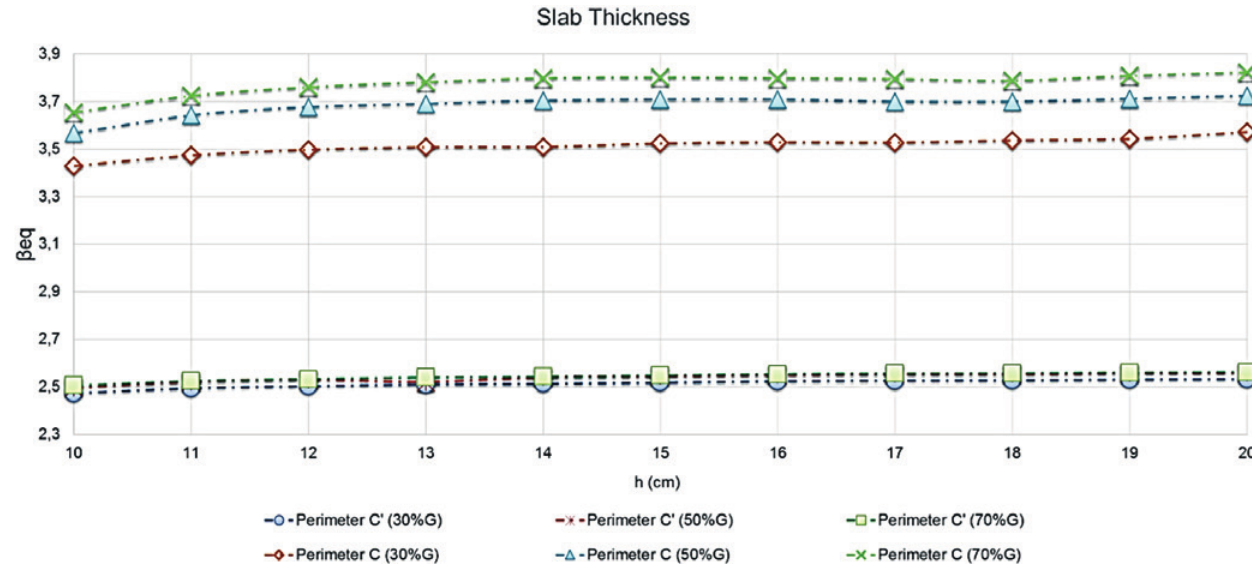
for rectangular column considering the variation of the slab thickness